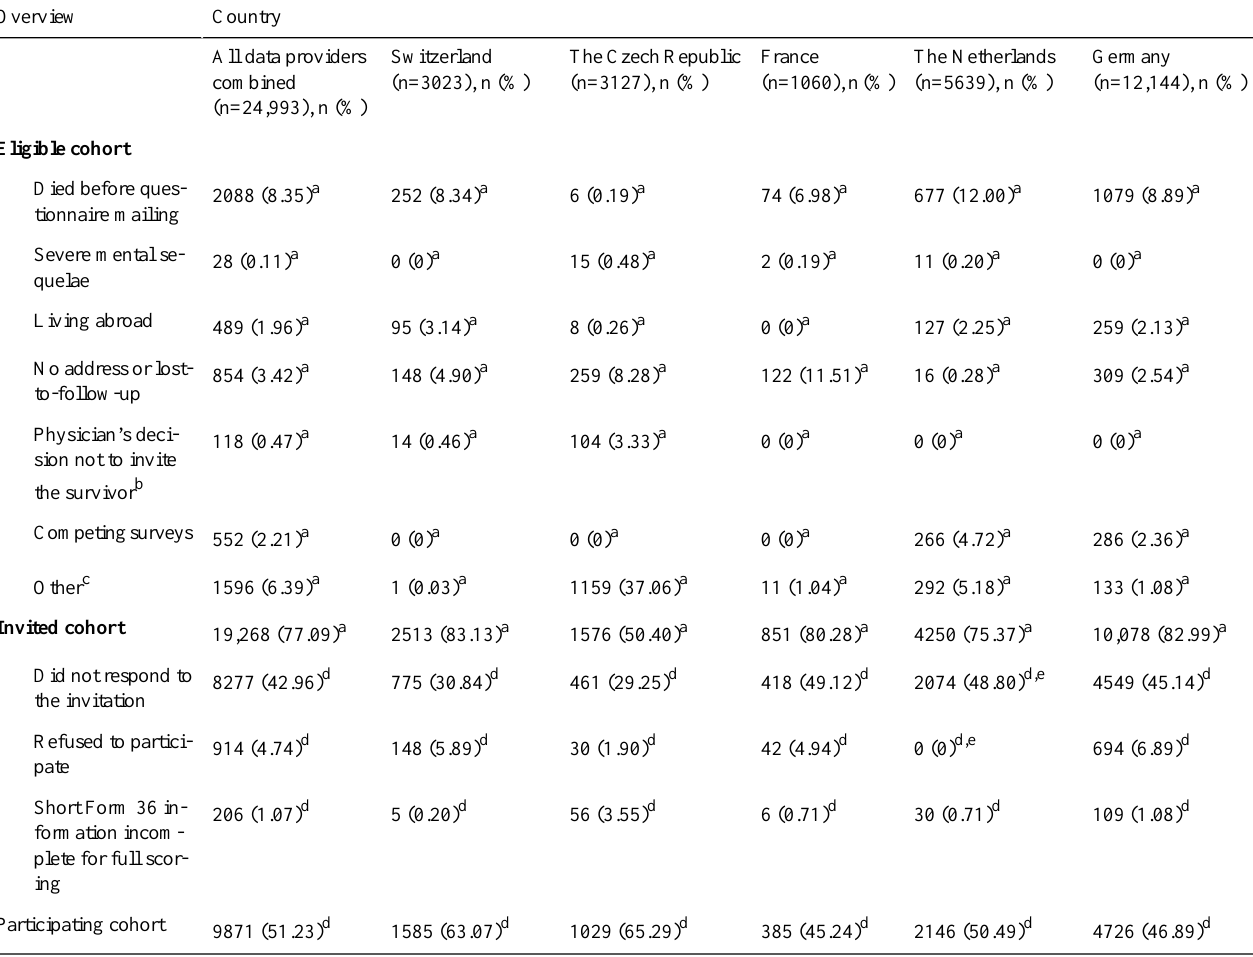
Table 3. Overview of eligible, invited, and participating survivors in the health-related quality of life Short Form 36 questionnaire study, overall and by